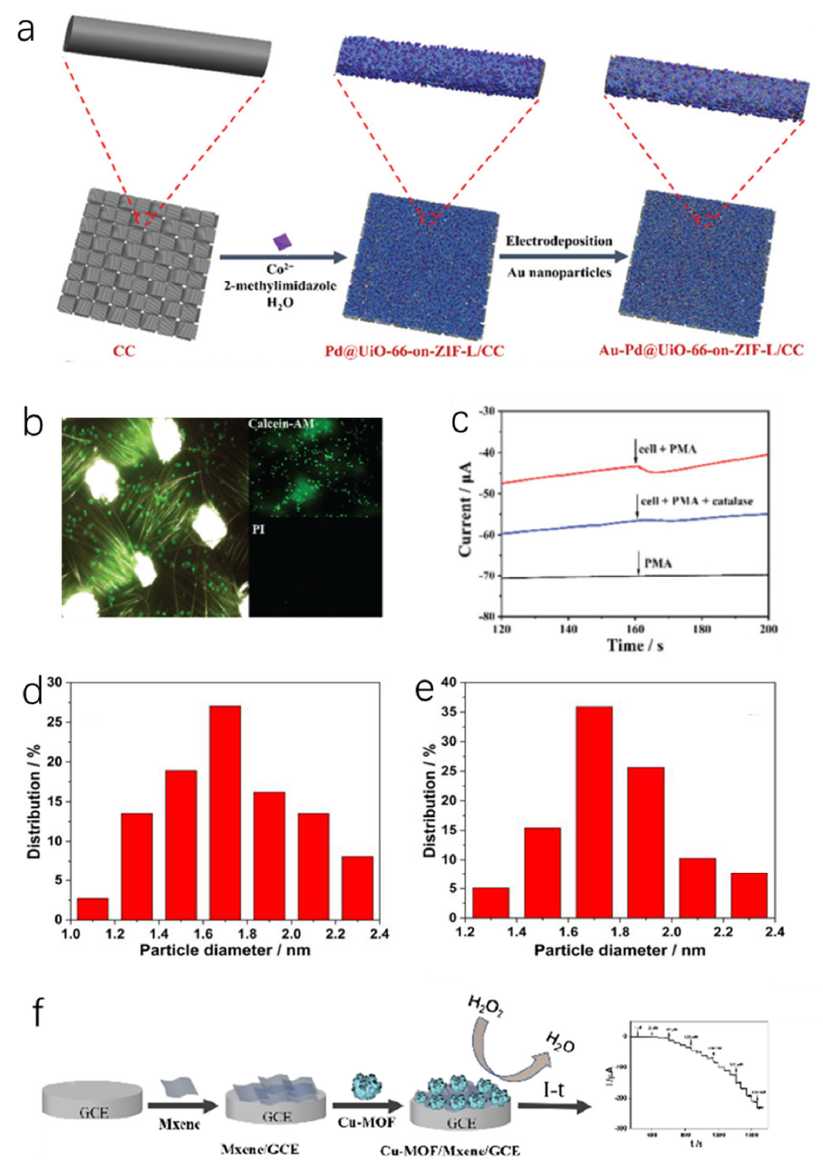
Figure 5. ( a ) Schematic diagram of the synthesis of Au–Pd@UiO-66-on-ZIF-L on CC; ( b )